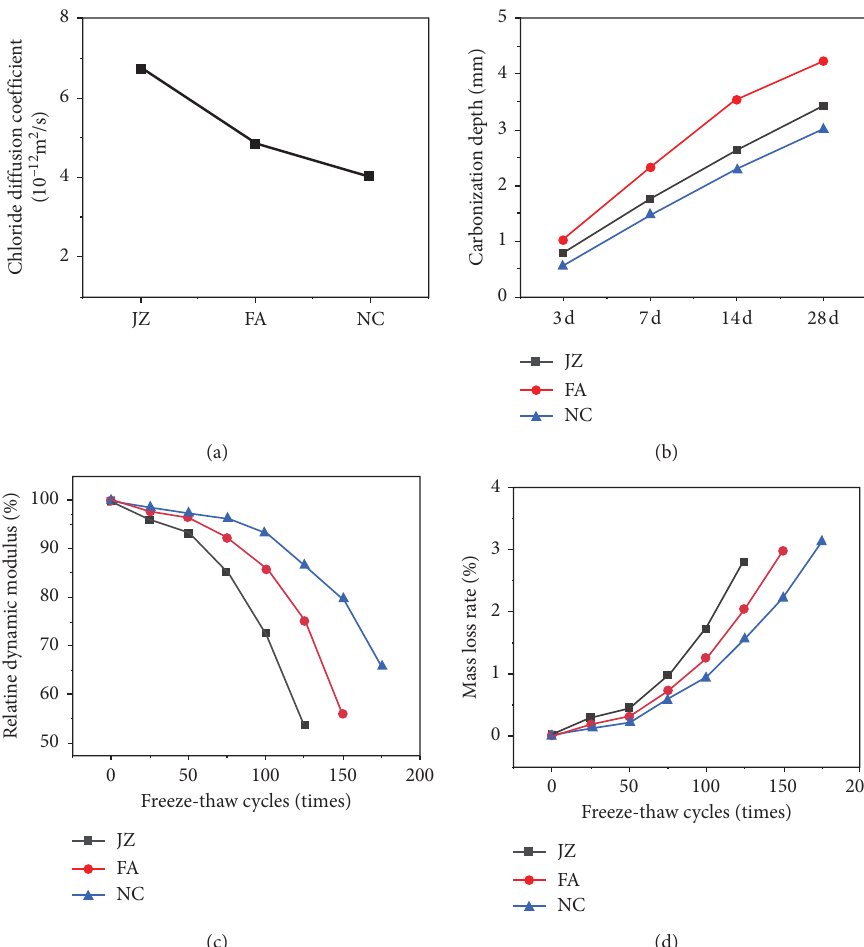
Figure 4: The results of durability tests: (a) chloride diffusion coefficient; (b) carbonation depth; (c) relative dynamic modulus; (d) mass loss